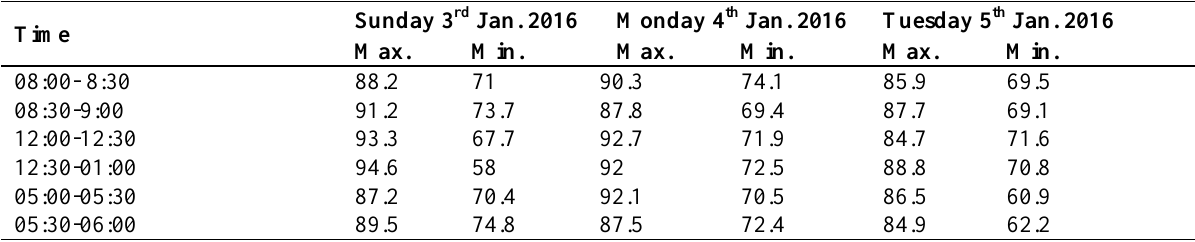
this belongs to the noise pollution levels that came from many shops of woodworkers and markets of food materials and greengrocers found on this site.